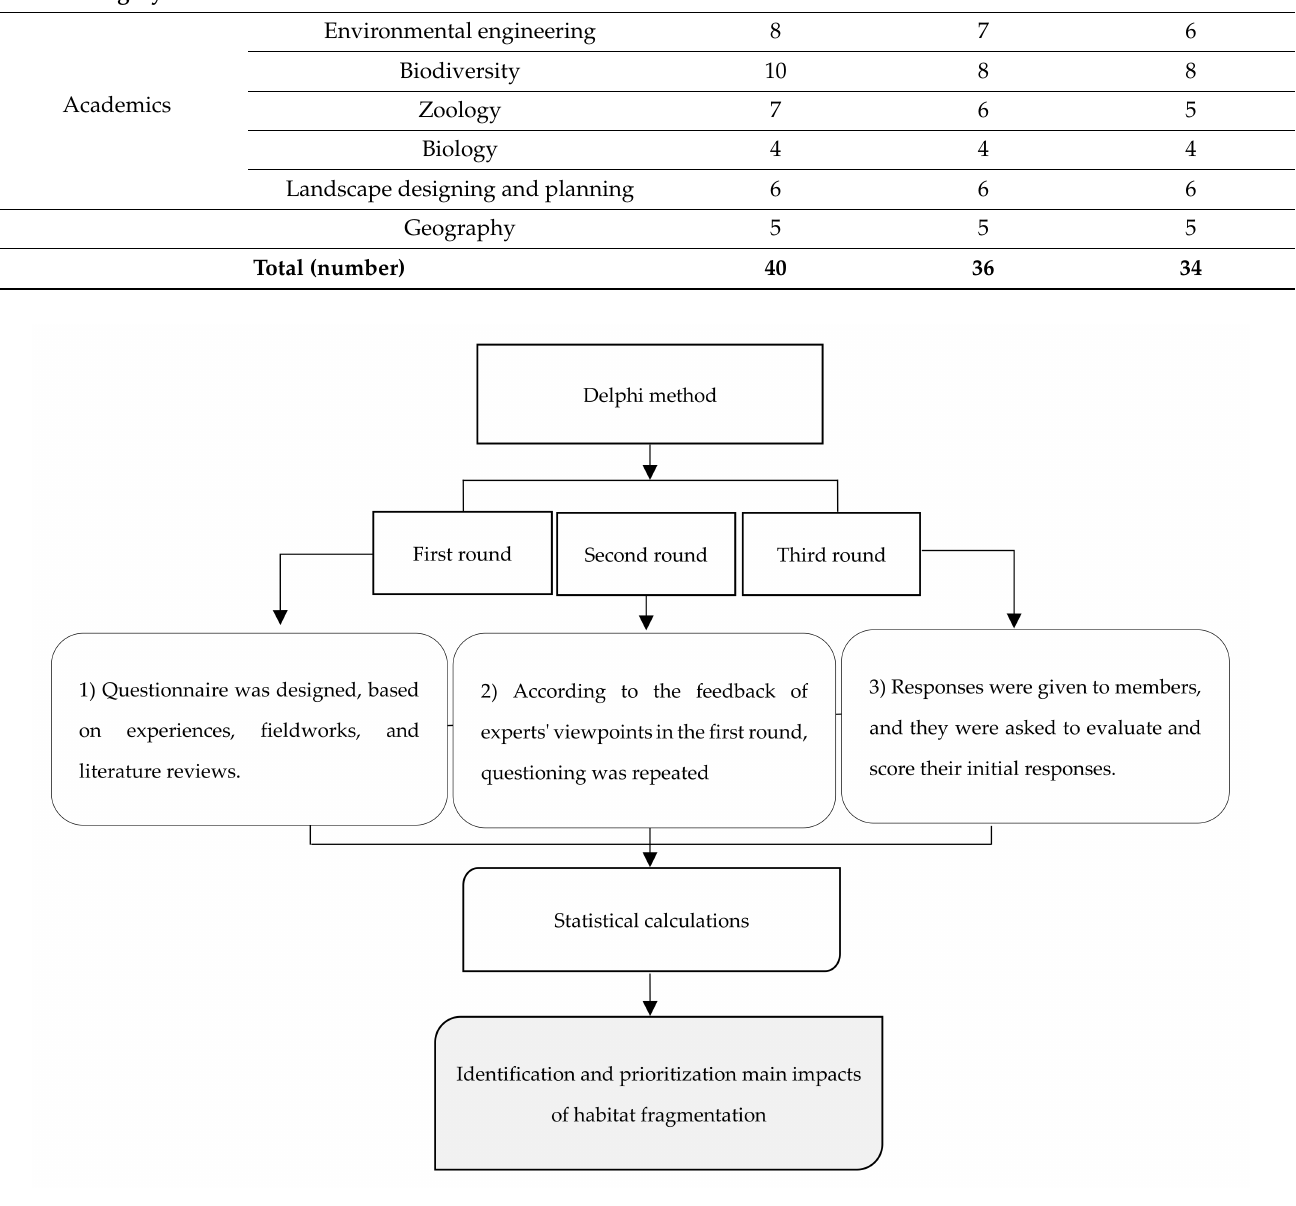
Figure 3. Main steps of the Delphi method, statistical calculation and detection of habitat